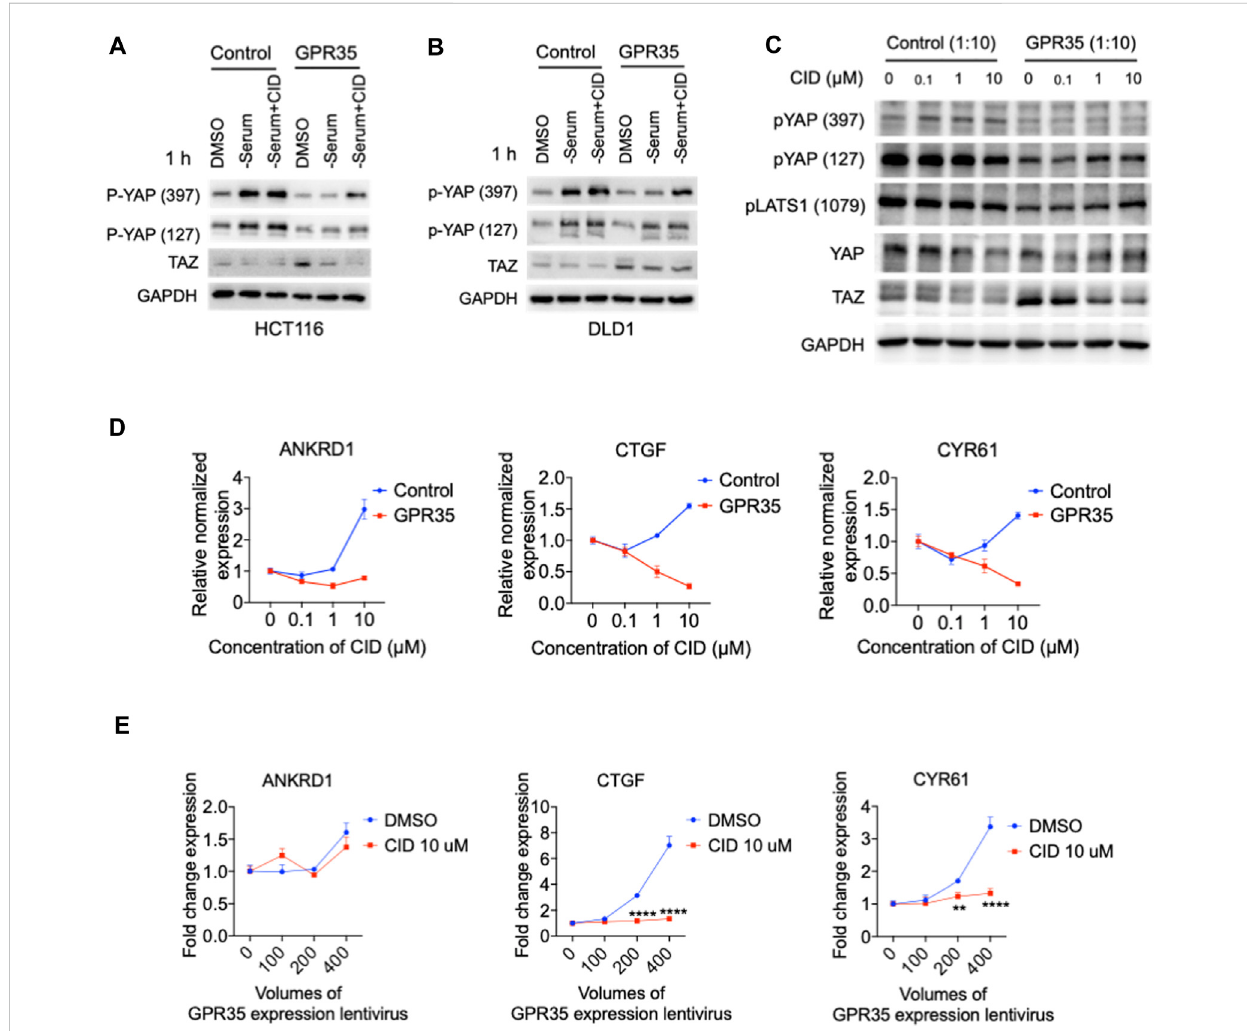
FIGURE 5 CID-2745687 inhibited GPR35-meditated YAP/TAZ activity. (A,B) Western blot assay on TAZ expression and YAP phosphorylationin established cell lines were challenged with serum deprivation for 1 h. Cells were subjected to fresh serum-free medium, and different CID concentrations were added simultaneously with serum-free medium. (C) Western blot analyzing expression and phosphorylation of YAP, TAZ, and LATS1 after treatment with different concentrations of CID. 293FT cells were infected with GPR35 expression lentivirus at the ratio of 1:10 for 24 h, and the different concentrations of antagonists were added directly to the medium. (D) mRNA expression of YAP/TAZ target genes after treatment of CID. (E) mRNA expressionofYAP/TAZtargetgenes.293FTcellswereinfectedwithdifferentvolumesofGPR35expressionlentivirusfor24 h,andCIDwasaddeddirectly to the medium for another 24 h. Then cells were harvested for PCR